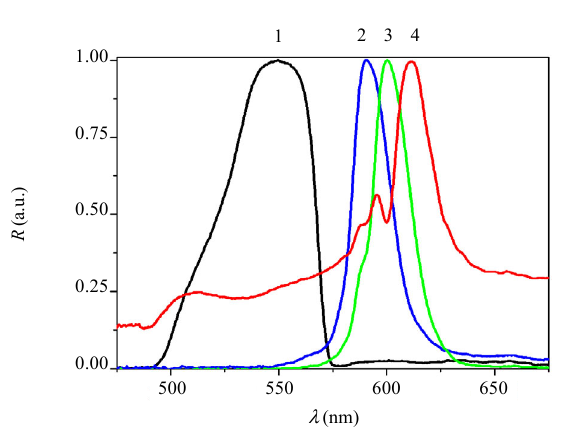
Fig. 4 Normalized reflection spectra for the AAO PC sample in dry state (1) and immersed in various liquids: water (2), water with 46 wt.% glycerol (3), and glycerol (4).